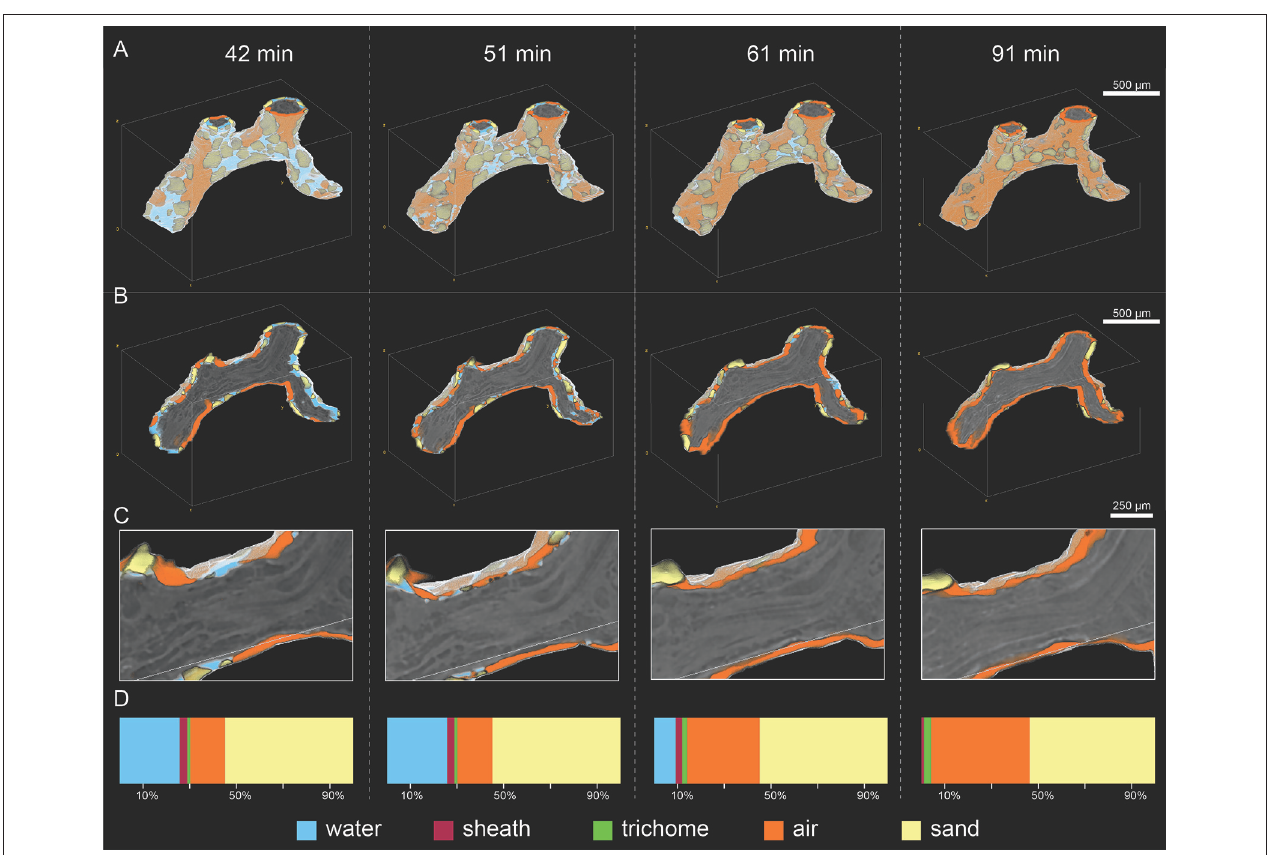
FIGURE 5 | Visualization of the full bundle (A) , a cross section of it (B) and a close-up cross section view (C) showing the distribution of water, air and sand in the 0–32 µ m microenvironment around the bundle during desiccation from 42 to 91min. Percent contribution of water, air, sand, trichome and sheath to the entire ROI are shown in panel (D)